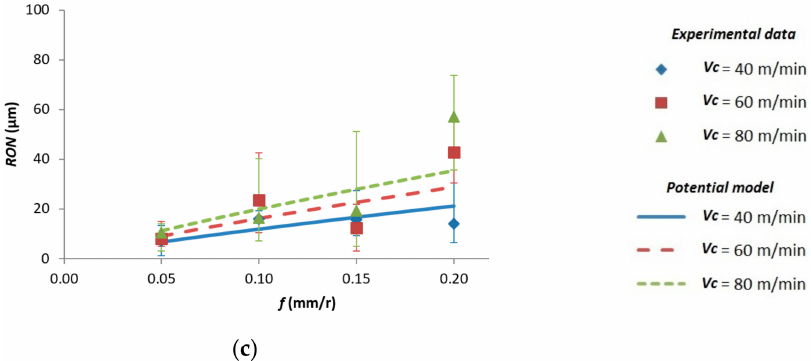
Figure 15. Potential models as a function of v c and f ( a ) straightness, ( b ) circular run-out and ( c ) roundness.